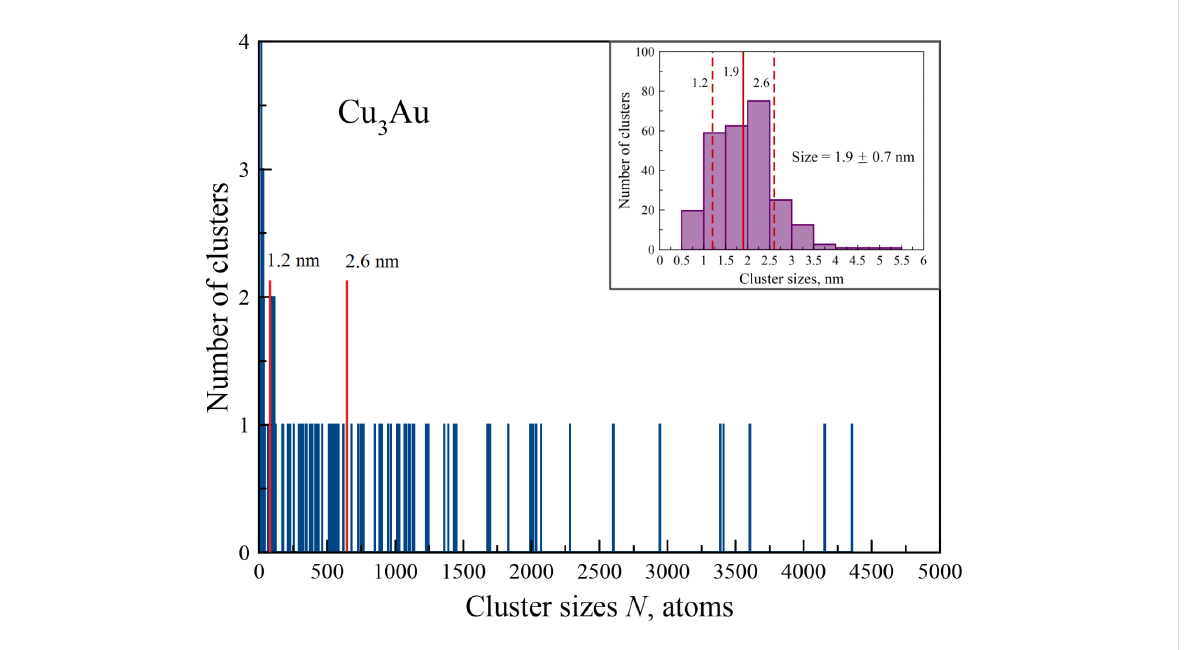
Figure 1: Size distribution of binary nanoparticles with the target composition of Cu 3 Au at a temperature of T = 1380 K. The MD simulation time is t = 5.5 ns. The inset shows the experimental size distribution based on the data presented in [3] for Cu 3 Au nanoparticles obtained by laser deposition.